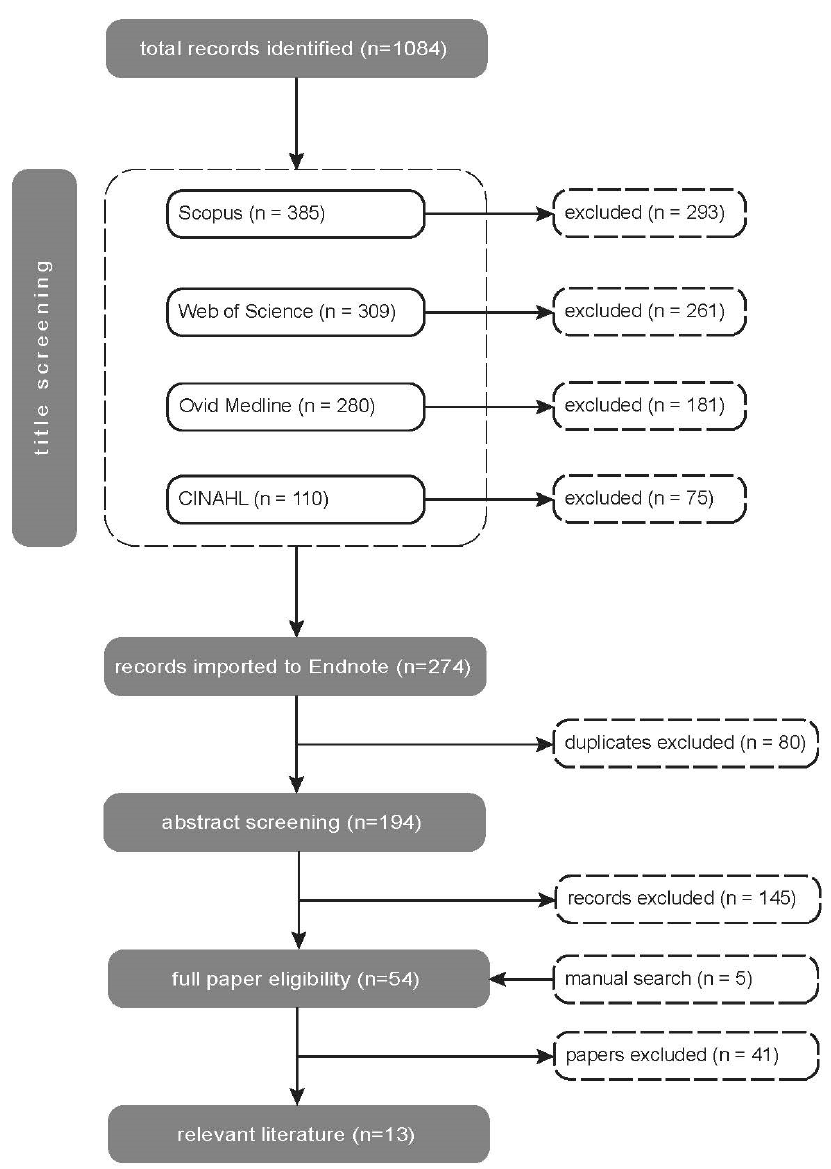
Figure 1. Diagram illustrating search and selection process.